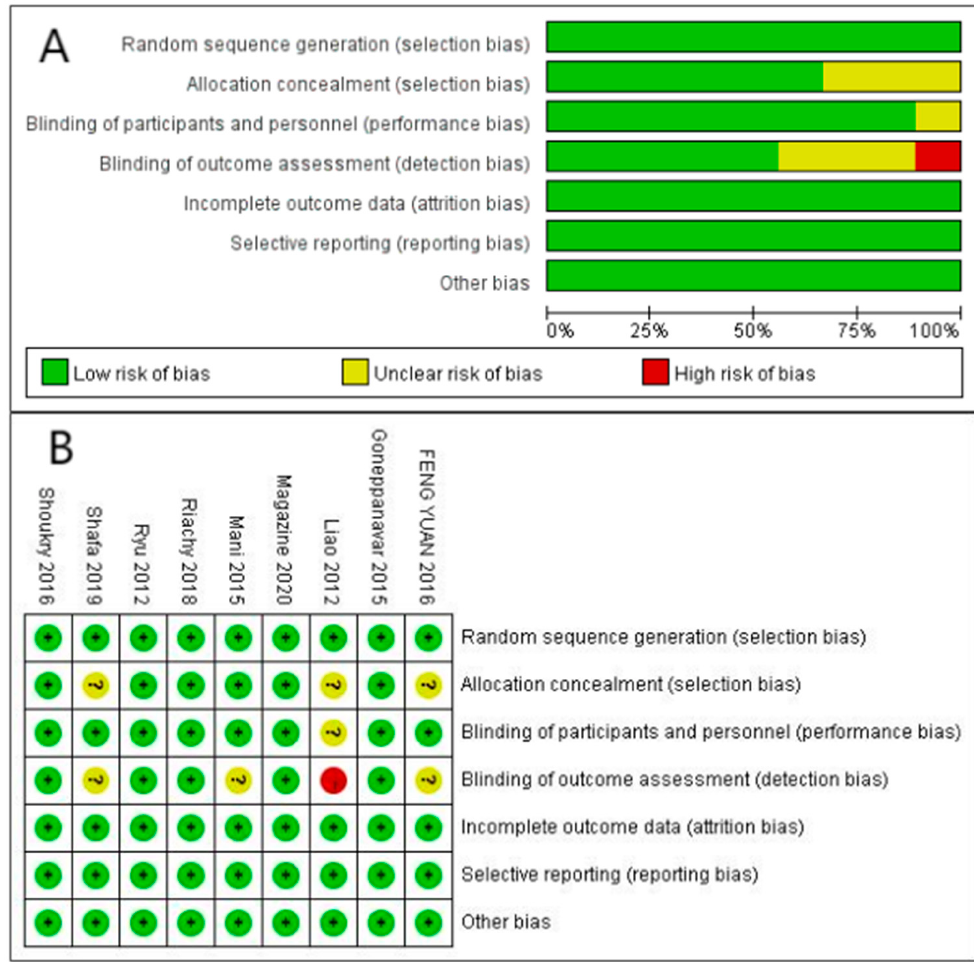
Figure 2. Risk of bias assessment. ( A ): Risk of bias summary. ( B ): Risk of bias graph. Green means low risk. Red means high risk. Yellow means unclear risk [22–24,27–32].